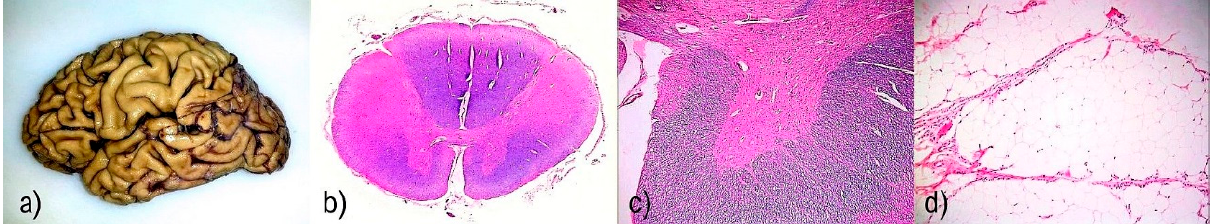
Figure 1. ( a ) Atrophy of the precentral gyrus together with atrophy of the frontal and temporal lobes may be present mainly in cases of ALS accompanied by dementia. ( b ) Marked atrophy and reactive astrogliosis of anterior horns, with atrophy of the anterior roots are the most striking findings in the standard staining method. Histochemical detection of myelin shows the most evident changes in the anterolateral cords in the forms of sclerosis. Stain: Luxol fast blue stain. ( c ) Detail of the described changes in anterior roots and horn. Stain: Luxol fast blue stain. The original magnification 200×. ( d ) Pronounced neurogenic atrophy and fatty pseudohypertrophy in the striated muscles of the respiratory muscles is a typical finding in ALS. Stain: Hematoxylin and eosin stain. The original magnification 200×.